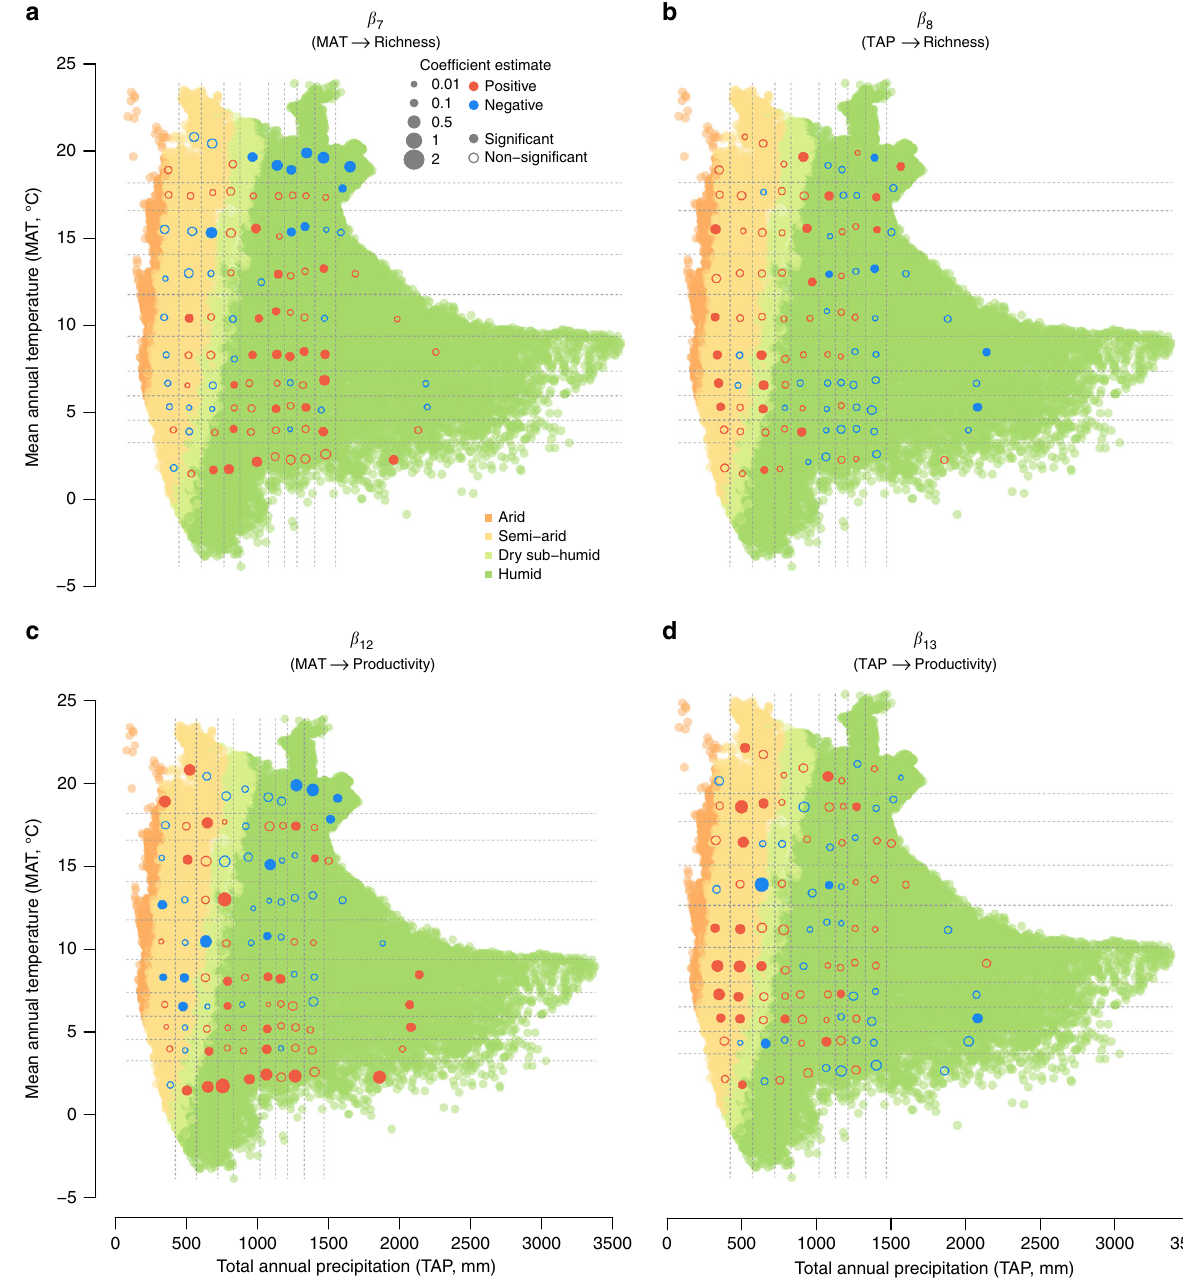
Fig. 4 Impacts of climate on richness and productivity in different climates. a Impacts of MAT on richness, b impacts of TAP on richness, c impacts of MAT on productivity, and d impacts of TAP on productivity. Coef fi cient estimates of the relationship for each climatic unit are plotted based on the means of MAT and TAP within the climatic unit on the MAT-TAP space illustrated in Fig. 1. Signi fi cance of the coef fi cient is evaluated based on whether the 95% credible interval (CI) overlaps zero. A list of coef fi cient estimates with its 95% CI is available in Supplementary Data